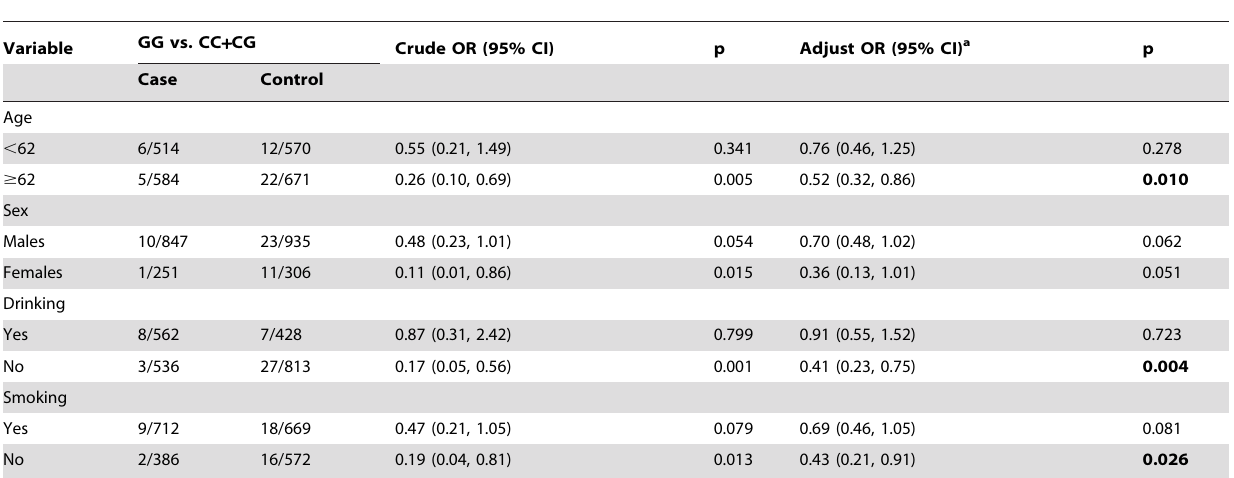
Table 4. Stratified results for pri-miR-124-1 rs531564 C . G by age, sex, drinking and smoking.